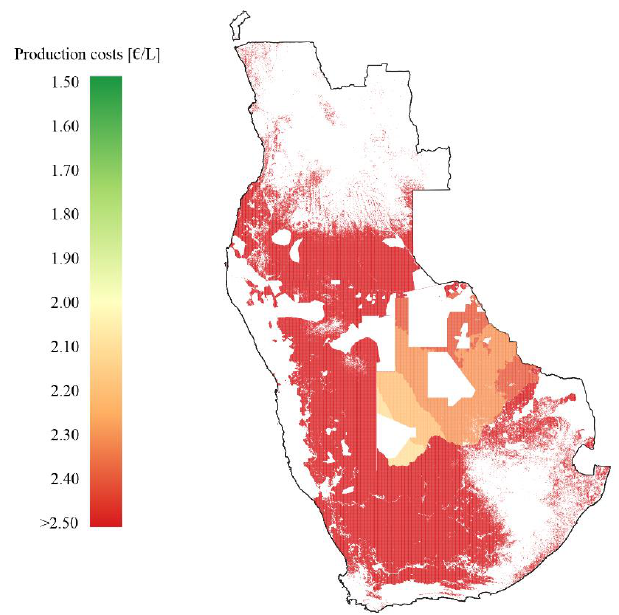
Figure A10. Production costs of solar thermochemical jet fuel in Southern Africa.